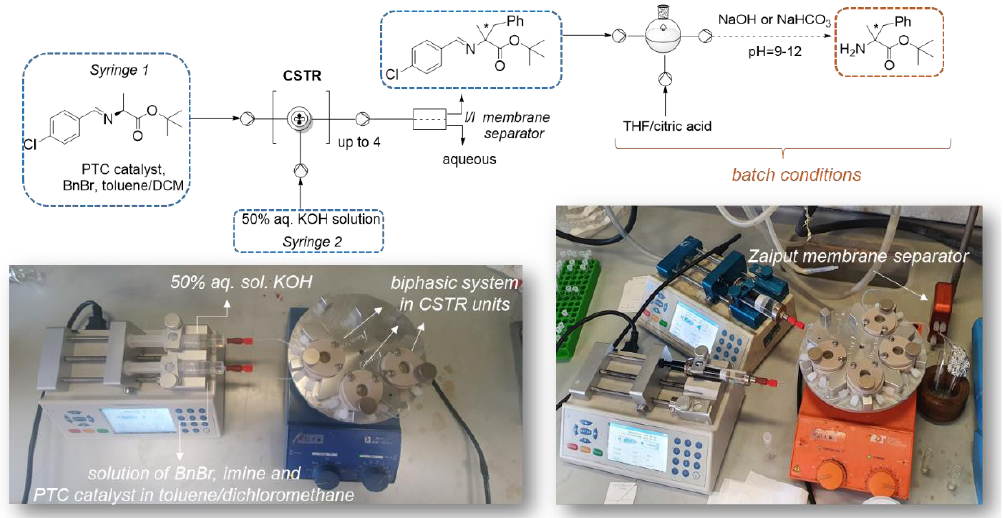
Figure 2. Liquid-liquid phase transfer benzylation in CSTR.